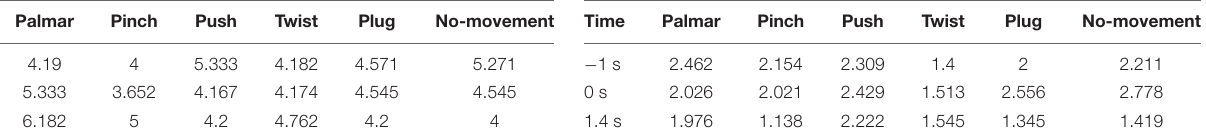
TABLE 6 | The average path length of network for each condition of